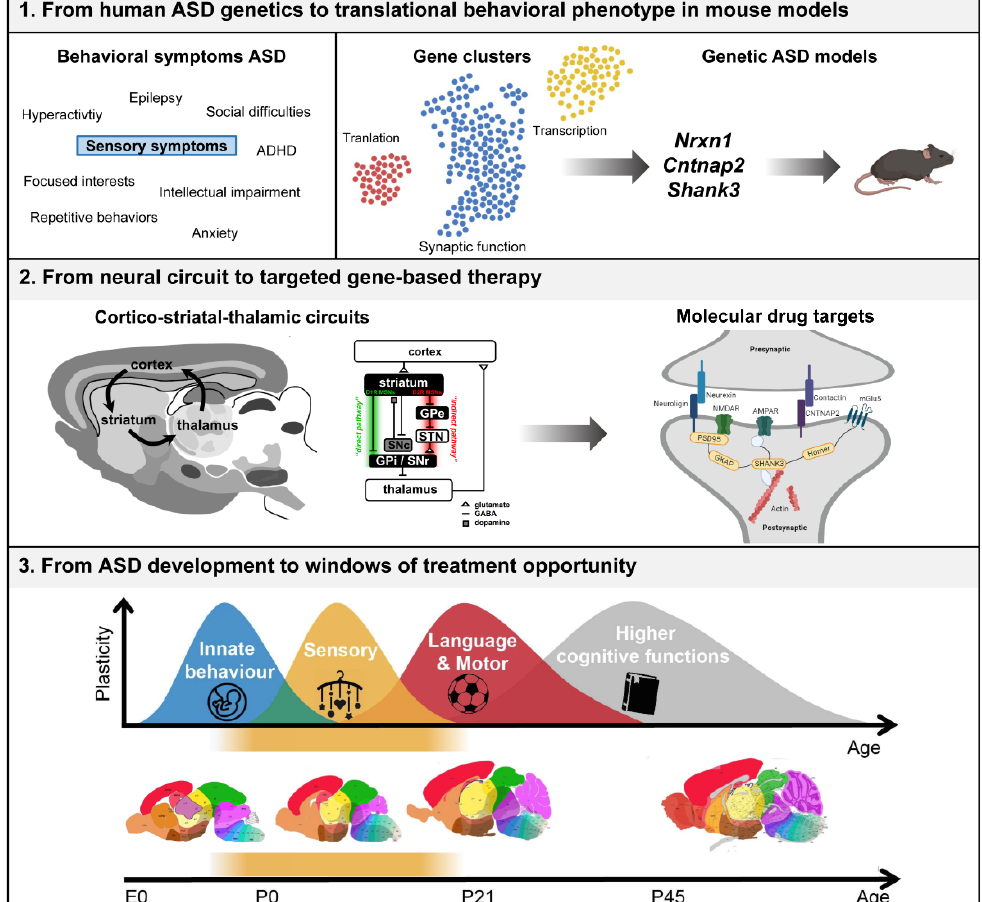
Figure 1. Schematic overview of the development of targeted gene-based therapy for ASD by studying spatiotemporal gene functions in rodent models. Abbreviations: MSN, medium spiny neuron; GPe, globus pallidus pars externalis; GPi, globus pallidus pars internalis; SNc, substantia nigra pars compacta; SNr, substantia nigra pars reticulate; STN, subthalamic nucleus; D1R, D1-type dopamine receptor; D2R, D2-type dopamine receptor. The figure is based on previous reviews, adapted and partly created with BioRender.com [56,117–120].